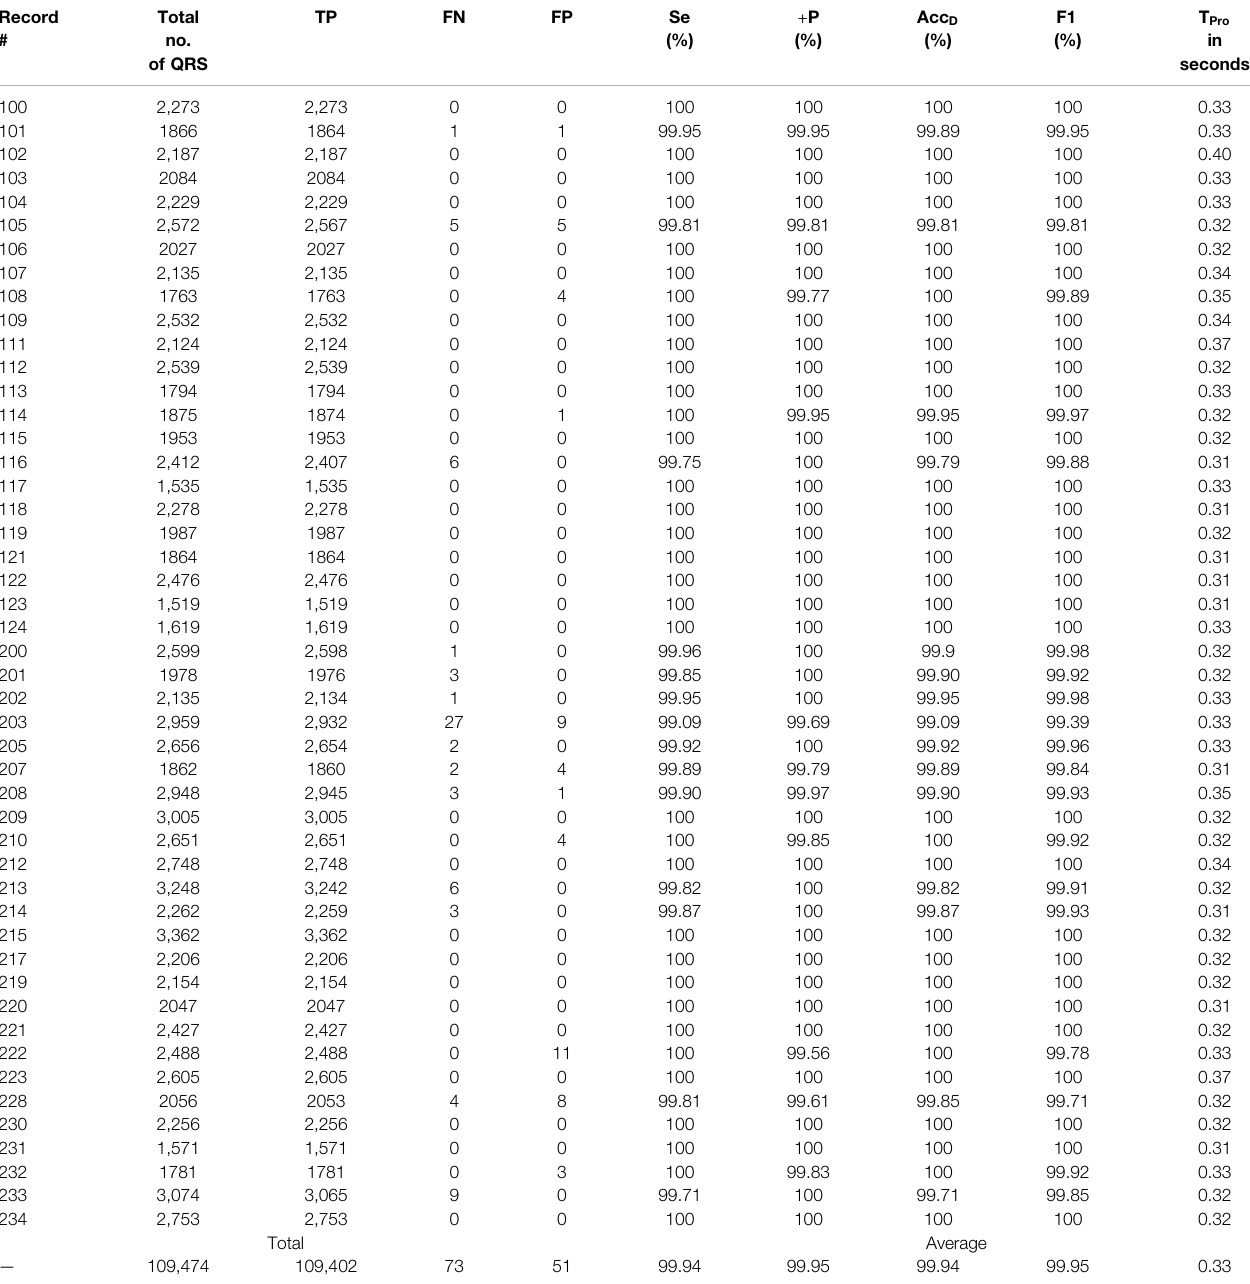
TABLE 3 | Performance of proposed RFB-based QRS-complex detection algorithm on MITDB. Record Total # no.